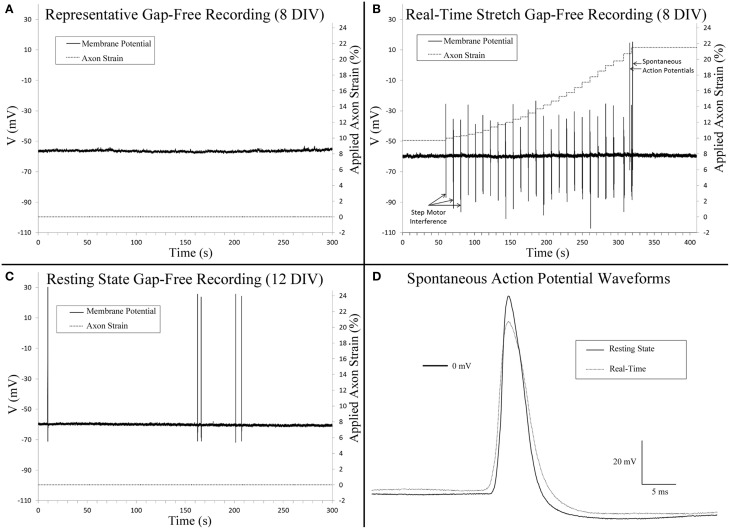
Gap-free patch clamp recording. (A) Cervical DRG neurons generally did not fire spontaneous action potentials within 10 min recordings. (B) Isolated spontaneous action potentials were evident in a single cell during real-time stretch upon reaching an axon strain of 21.5%. Step motor interference reflects programmed stretch steps which occur at a frequency of 0.1 Hz (Table 1). Control recordings confirmed that interference spikes originated from the stepper motor and not cells. (C) A single cell at rest fired five spontaneous action potentials. (D) A comparison of spontaneous action potentials obtained from (B,C) revealed that peak voltage was reduced by 11.6 mV in the cell undergoing real-time stretch.